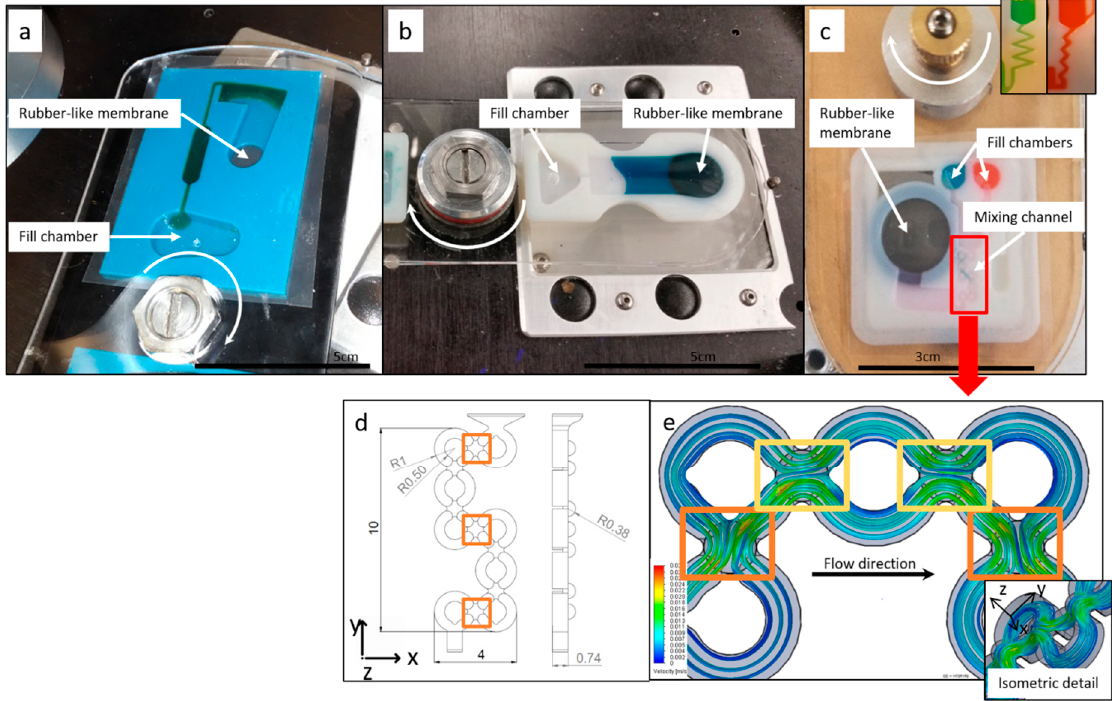
Figure 3. Three different reciprocation inserts are shown mounted on the spin stand. In all cases, liquid is loaded into the fill chamber(s) and then released by overcoming capillary forces in outlet channel (burst valve). ( a ) Reciprocation insert based on compression of air and elastic deformation of rubber-like membrane. ( b ) Straight-channel reciprocation insert to decouple printed micro-balloon performance, used for testing of the rubber-like membrane for possible fatigue. ( c ) Mixing insert allowing for the mixing of two components during reciprocation. ( d ) Major dimensions of the mixing channel [in mm]. ( e ) Water flow path during reverted flow simulation at a 200 μ L/min flow rate; the orange marks show locations of increased liquid interchange between merging and separating channels and the yellow marks show locations with less liquid interchange between merging channels (compare over-crossing of green).